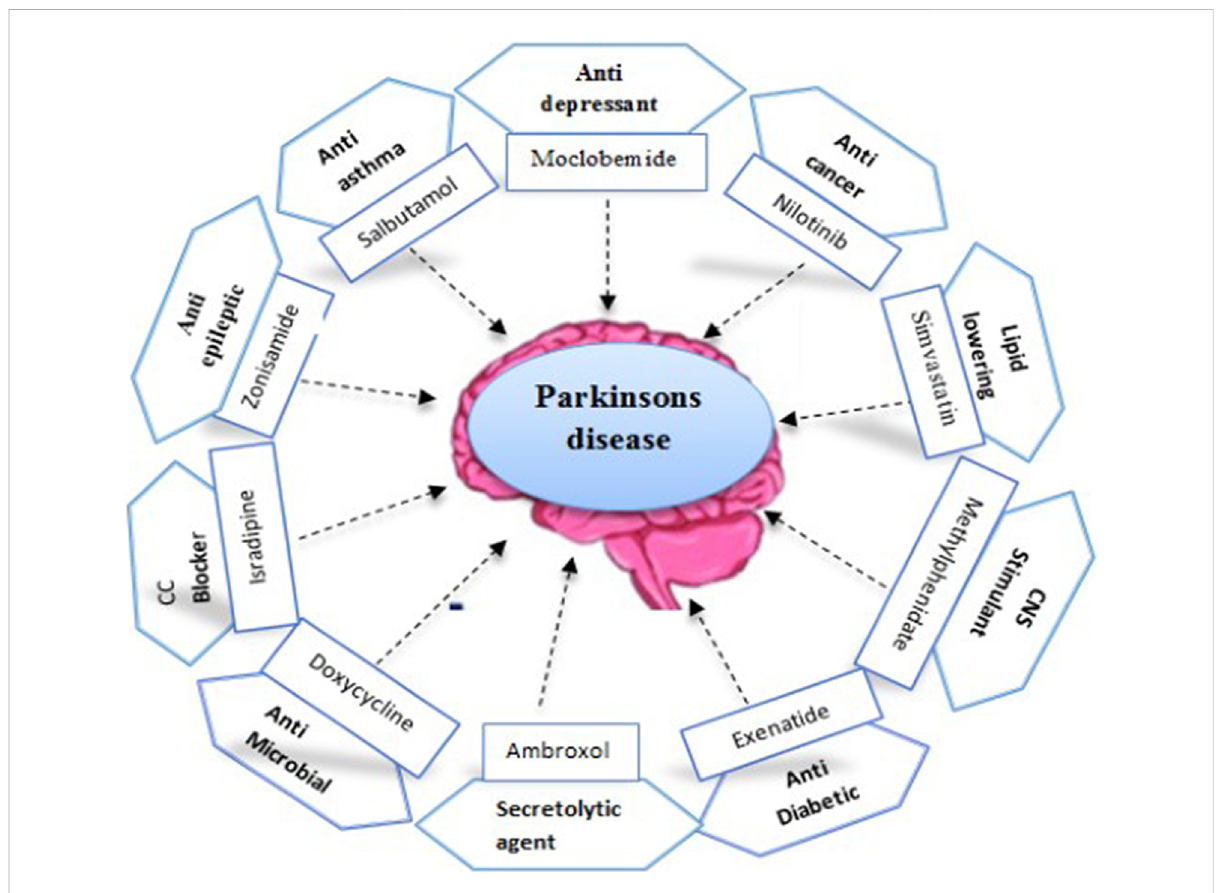
FIGURE 2 Repurposed drugs tested in clinical trials for Parkinson ’ s